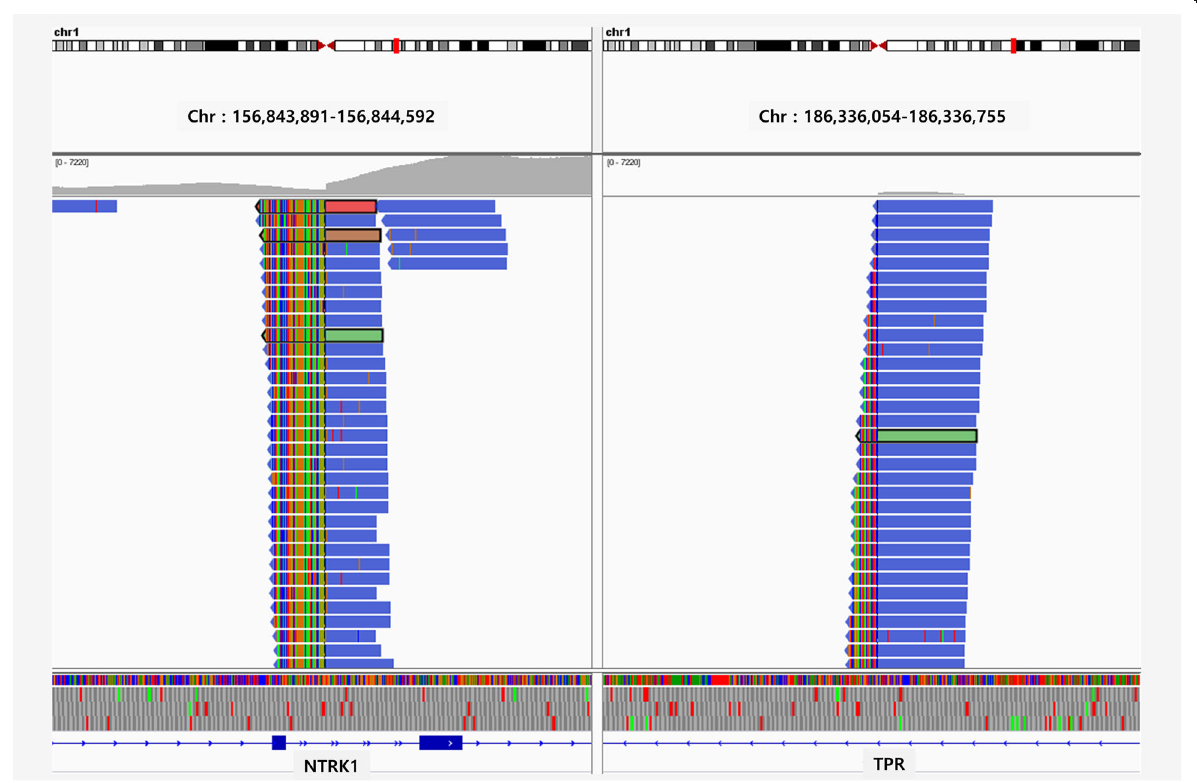
Fig. 6 The custom NGS panel revealed TPR-NTRK1 fusion (IGV